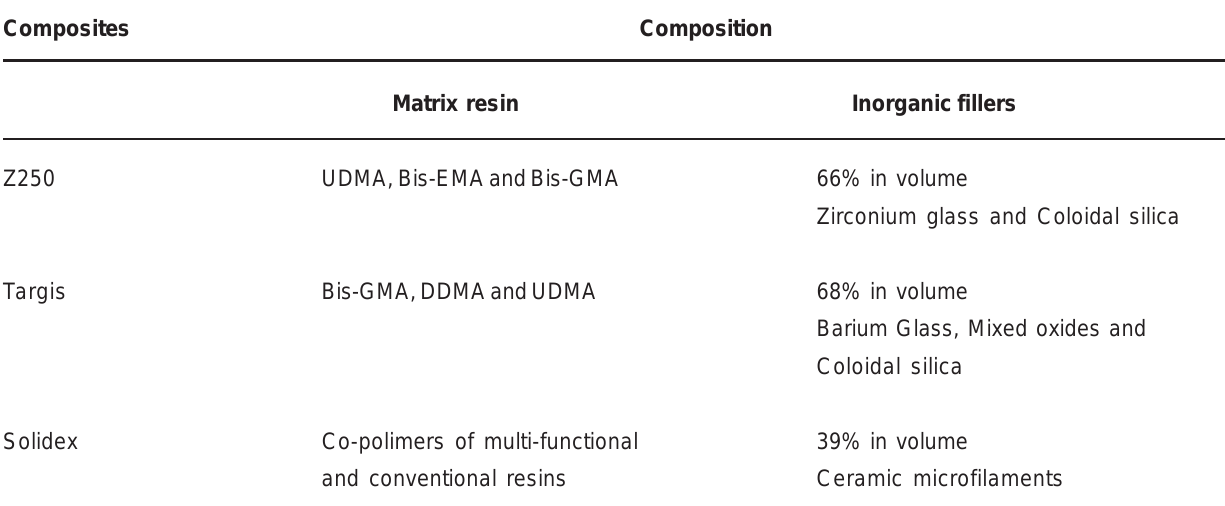
TABLE 1 - Composition of restorative resin material used in this study